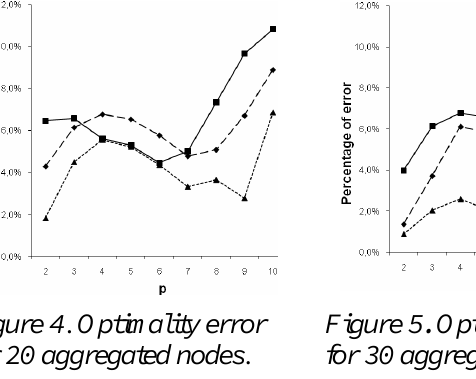
Figure 4 . Optimality error for 20 aggregated nodes .